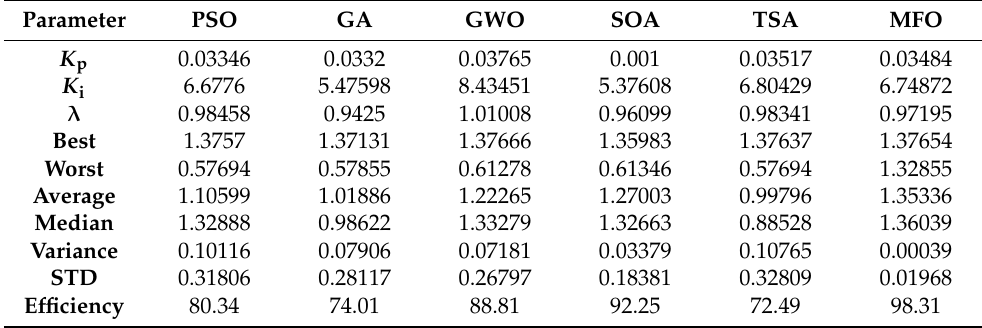
Table 1. Best parameters of IFMPPT and numerical evaluation (30